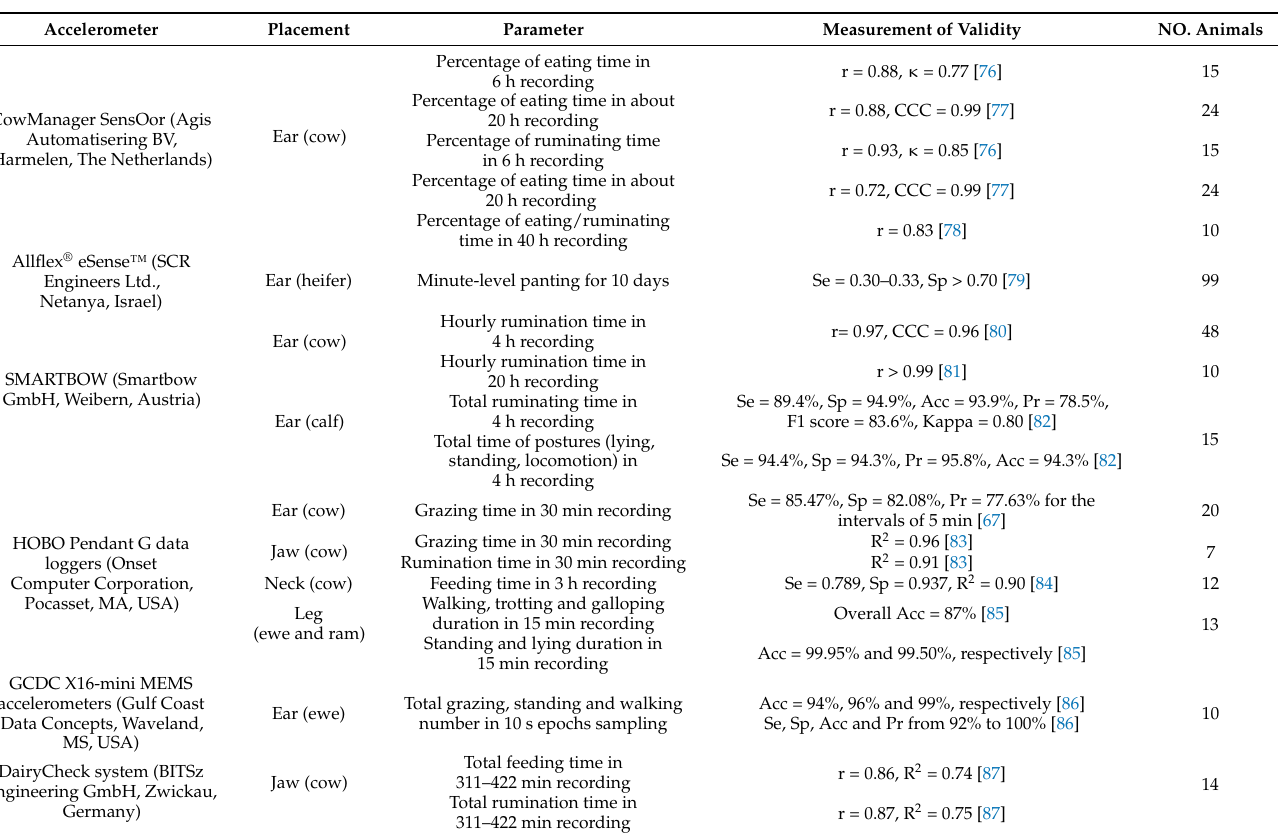
Table 1. The accelerometer systems used for the validation of behavioral activities. r = correla- tion coefficient (Pearson or Spearman’s rank), Acc = accuracy, Se = sensitivity, Sp = specificity, Pr = precision, Kappa = κ , F -score, CCC = concordance correlation coefficient, and R 2 = coefficient of